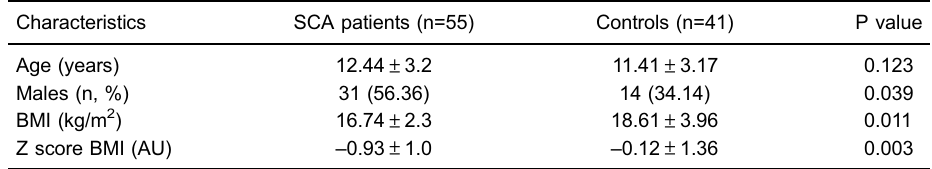
Table 1. Clinical characteristics of the study participants. Characteristics